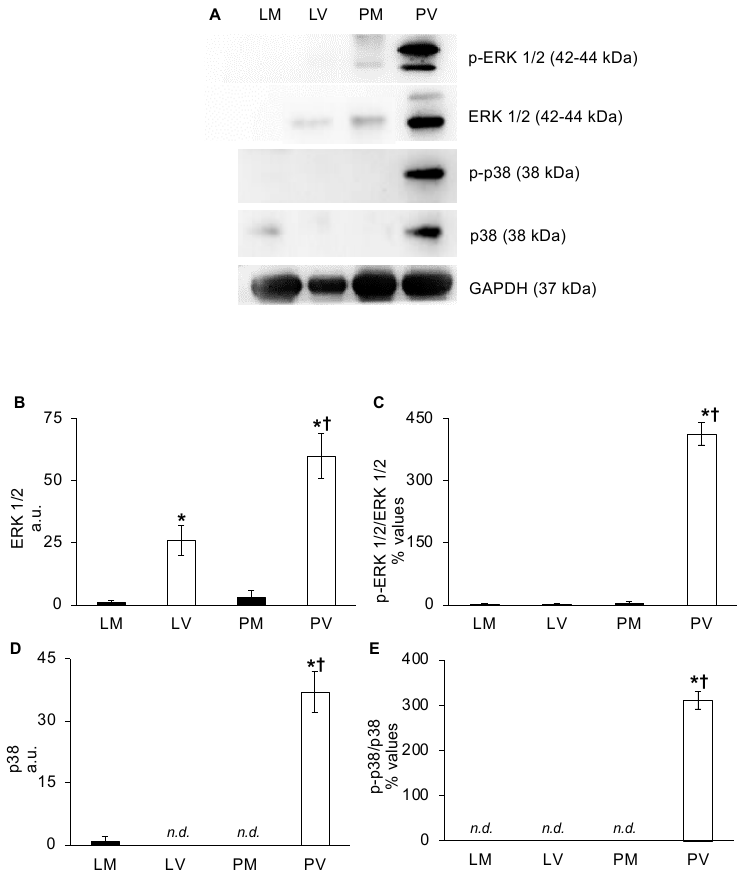
Figure 3. VEGFR2 signaling pathway activation: total and phosphorylated ERK1/2 and p38 in whole mice ovaries. Representative western blot images of ERK1/2 and p38 total and phosphorylated form (p-ERK1/2 and p-p38, respectively) of late-reproductive multiparous (LM) and virgin (LV), and post-reproductive multiparous (PM) and virgin (PV) mice ( A ). ERK1/2 ( B ) and p38 ( D ), values are expressed as arbitrary units (a.u.), considering LM values arbitrarily as 1. The p-ERK1/2/ERK1/2 ( C ), and p-p38/p38 ( E ) values are expressed as percentages (%) of the ratio of phosphorylated/total protein. Bar graph data represent the mean ± SEM ( B , D ) and the mean percentage ± relative error ( C , E ) after normalization of each protein with the respective actin used as loading control of at least four independent determinations. (†) indicates significant difference ( p < 0.05) related to age (LM vs. PM; LV vs. PV); (*) indicates significant difference ( p < 0.05) related to parity status (LM vs. LV; PM vs. PV).